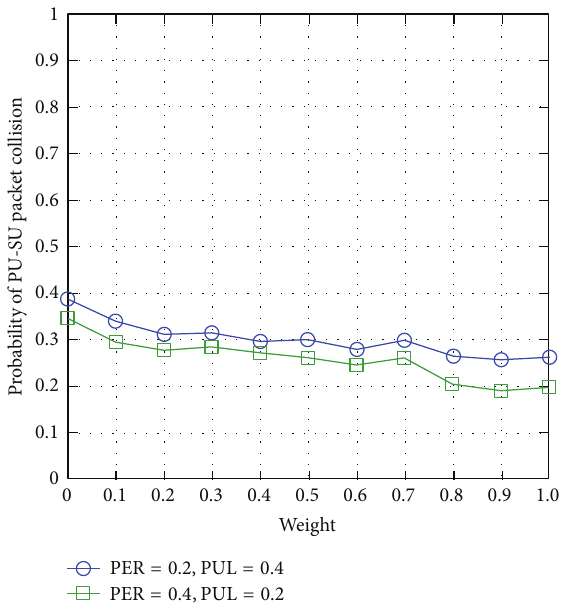
Figure 6: SUs’ interference to PUs for varying weight factor 𝜔 .